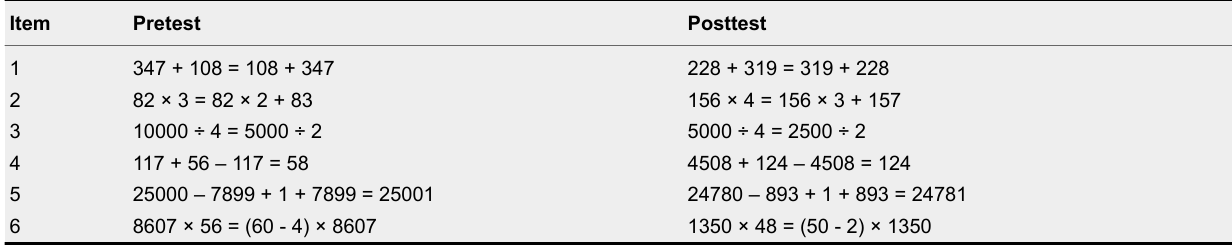
Items on the Relational Thinking Measure at Pretest and